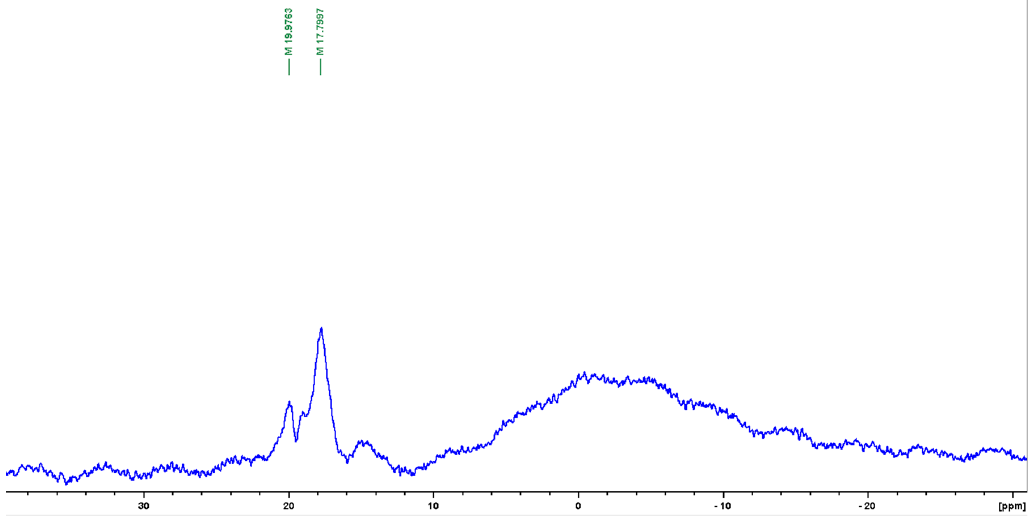
Figure 2. 11 B NMR spectrum of copolymer III in solution of chloroform-d.